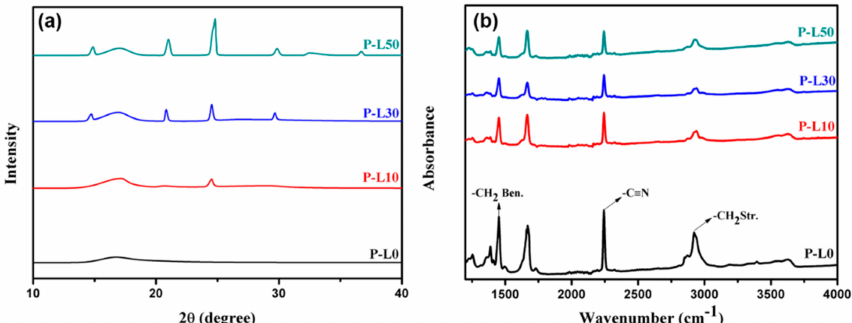
Figure 3. ( a ) XRD and ( b ) Fourier transform infrared (FT-IR) spectra of PL membranes.